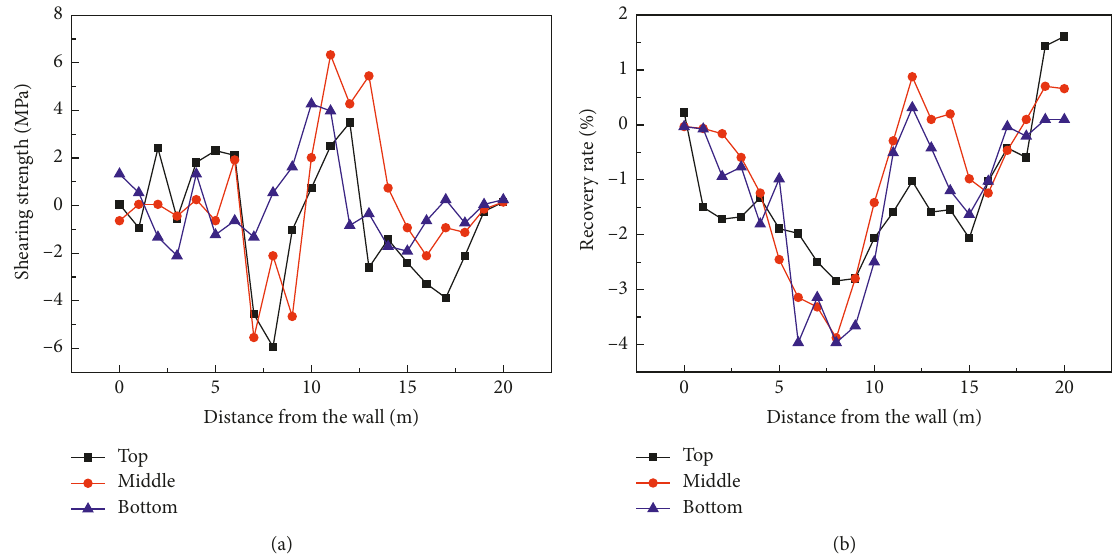
Figure 4: Distribution of shear stress in different layers of coal seam with 1.5m thickness and different strength: (a) medium-strength and (b) high-strength hard coal gangue.